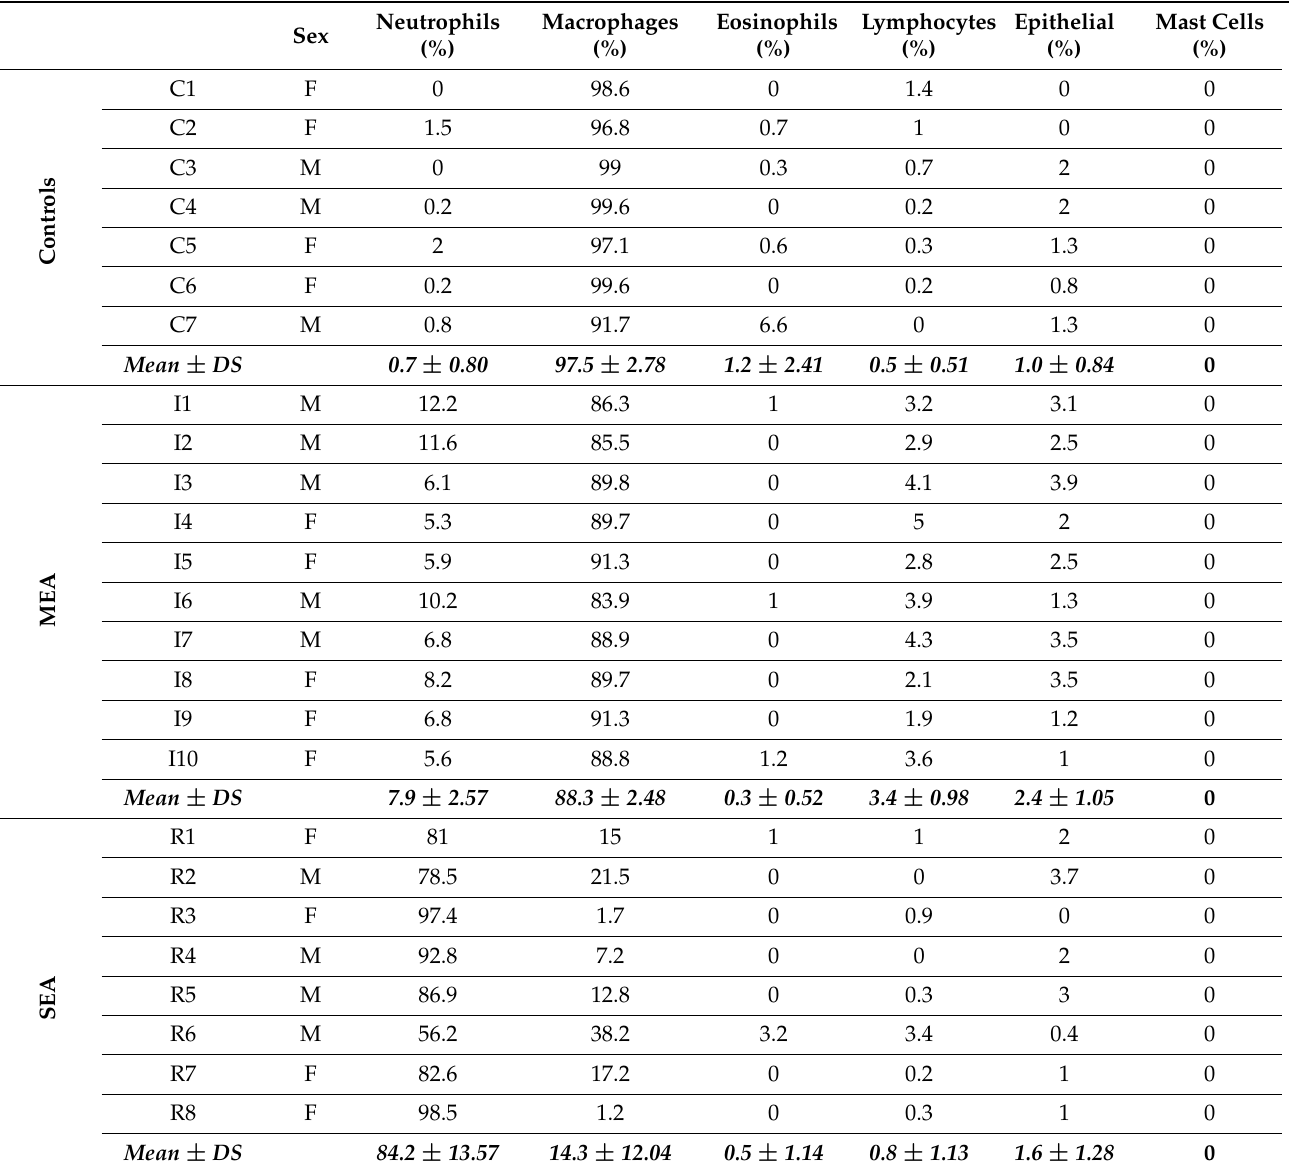
Table 1. Cytological and bacteriological examination results of BAL fluid samples from controls and MEA- and SEA-affected horses. The percentage value of the inflammatory cells (neutrophils %, macrophages %, eosinophils %, and lymphocytes %) was obtained by performing a 200 inflammatory cell count per sample on the stained slides. Then, a further count was performed, taking into account a total of 200 cells per slide and recording only the exfoliated respiratory epithelial cells (epithelial %). Neutrophils Macrophages Eosinophils Mast Sex (%) (%) (%) (%) (%)